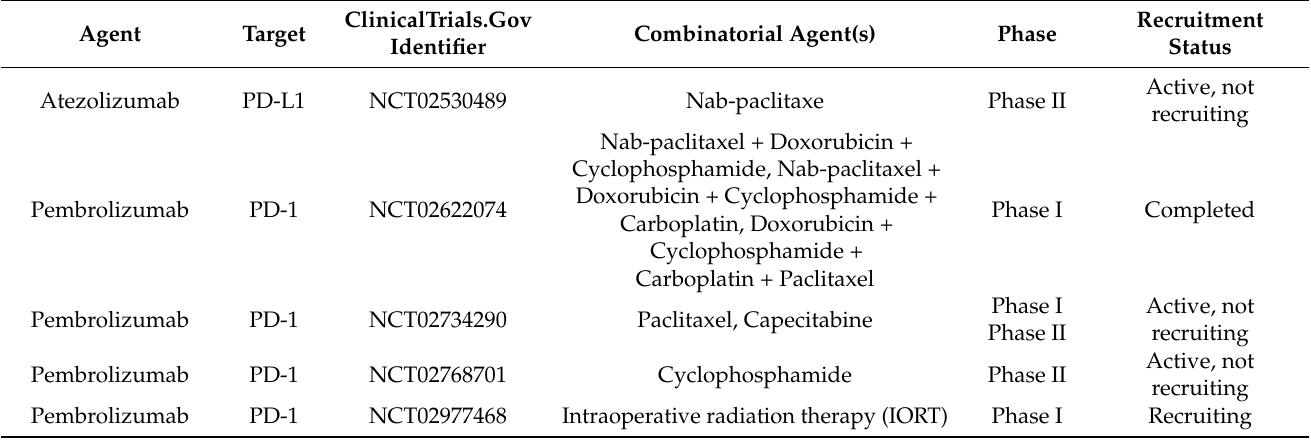
Table 1. Status of clinical trials with immune checkpoint blockade reagents for the treatment of TNBC [30].